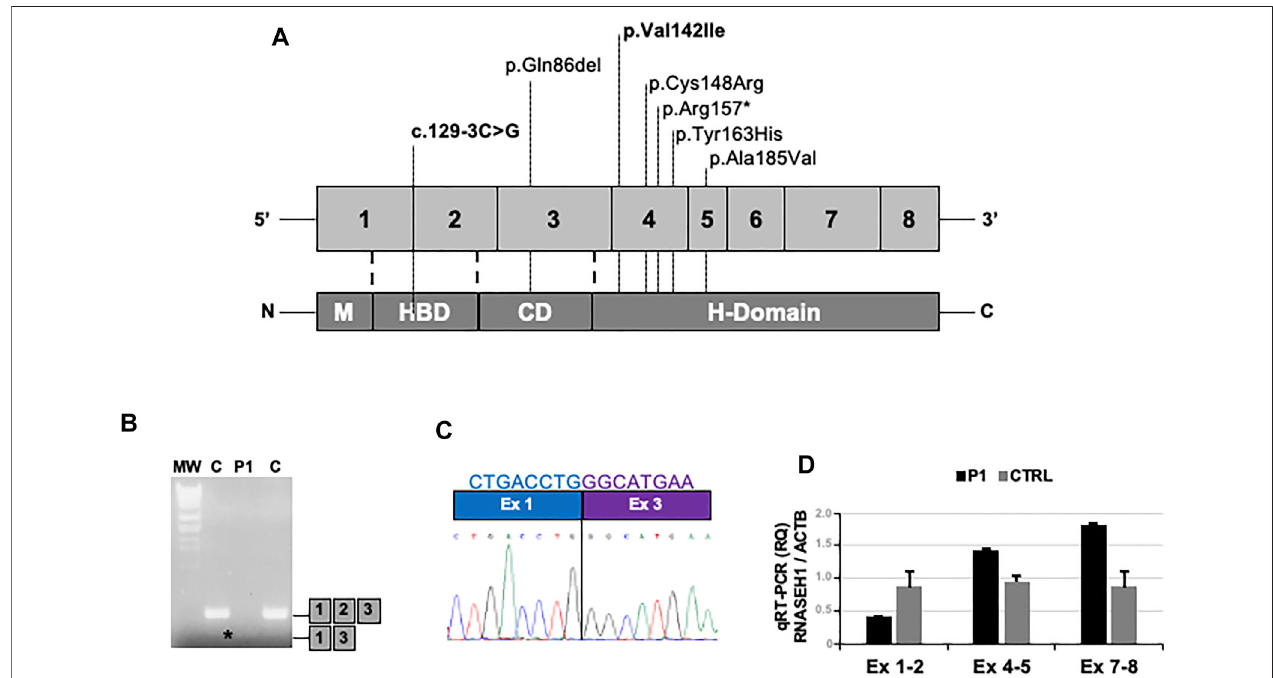
FIGURE 3 | – Molecular studies. (A) Schematic representation of the RNASEH1 gene and protein structure, showing the location of all the pathogenic variants describedsofar;thosedetectedinthepresentworkarehighlightedinbold. (B) GelelectrophoresisofRT-PCRampliconsencompassingexons1and3inmusclesofthe proband (P1) and controls (C). Asterisk indicates the presence of an abnormal band in P1. (C) Sequence electropherogram showing the loss of exon 2 in the proband ’ s RT-PCR amplicon. (D) Quantitative RT-PCR analysisof RNASEH1 transcript showing the selective reduction ofthe signal ofthe probe targeting exon 1 – 2 junction in the proband ’ s muscle compared to